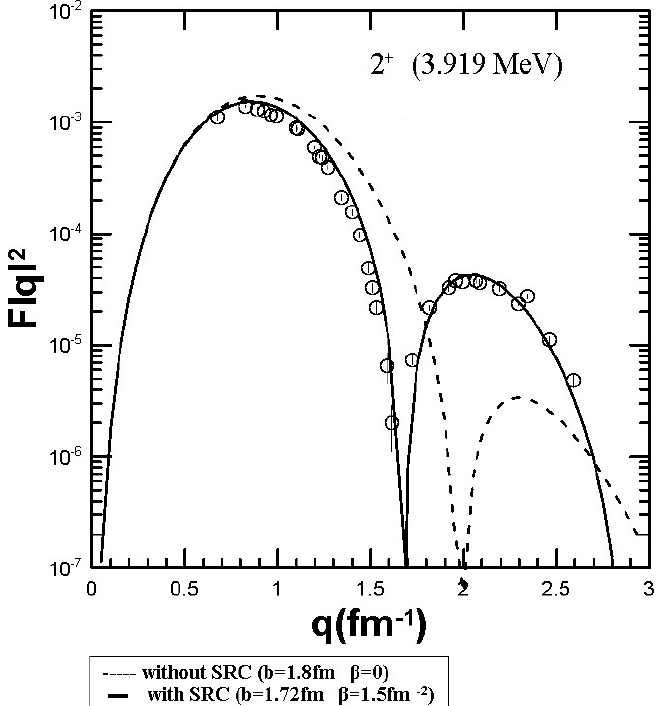
Fig. 2: Inelastic Coulomb 2 C form factors for the transition to the 12 + (3.919 MeV) state. The dashed and solid curves are the calculated 2 C form factors without and with the inclusion of the effect of the SRC, respectively. The open circle symbols are those of the experimental data taken from